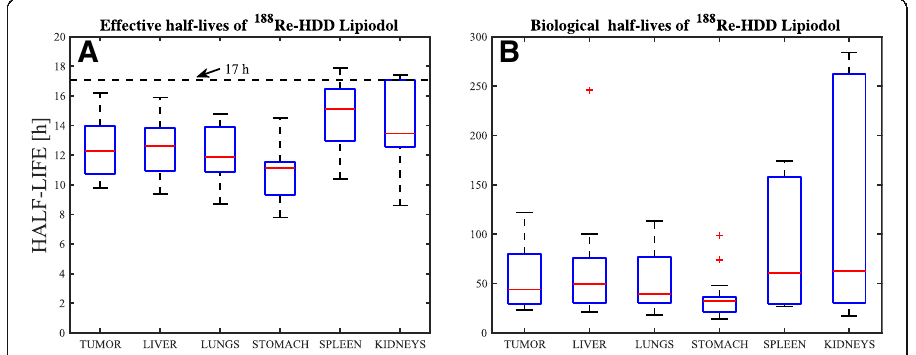
Fig. 4 Distributions of the effective ( a ) and biological ( b ) half-lives of 188 Re-HDD-Lipiodol in the tumor, liver, lungs, stomach, spleen, and kidneys. The horizontal dashed-line (sub-A) indicates the physical half-life of 188 Re (i.e., 17